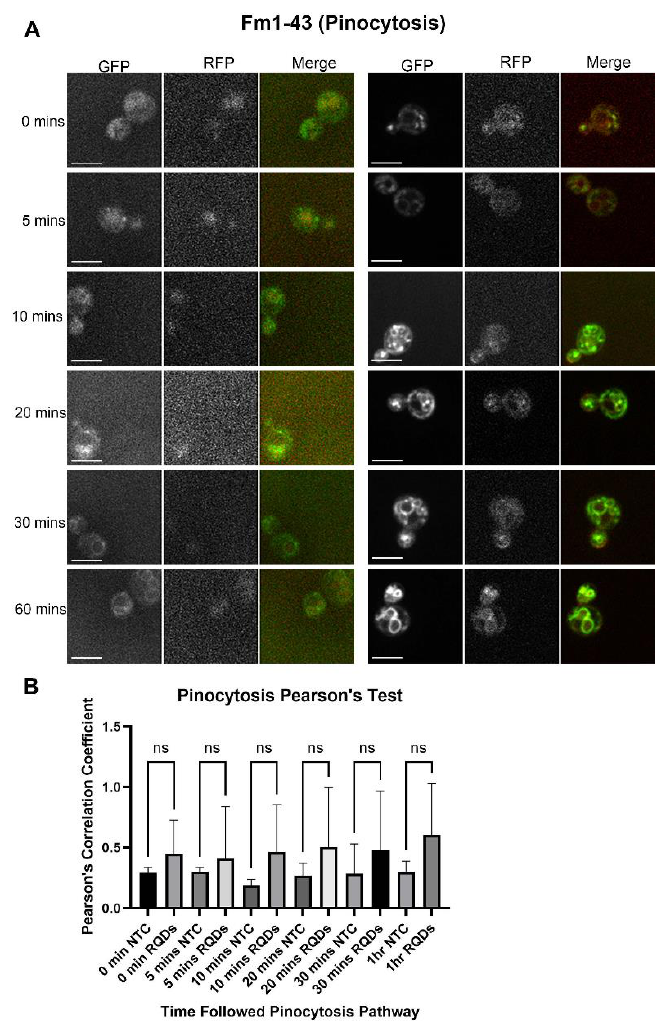
Figure 4. A pulse and chase experiment to determine the degree of colocalization between red quantum dots (RQDs) and green pinocytosis tracking dye Fm1-43. Fm1-43-labeled cells at 0 ◦ C were incubated at room temperature for varying durations up to 60 min. The size bar is equivalent to 5 µ m. ( A ) Confocal microscopy of the pinocytosis pathway within 60 min (left — untreated, right — treated) and ( B ) graph of Fm1- 43 and QDs colocalization assessed by Pearson’s coefficient.